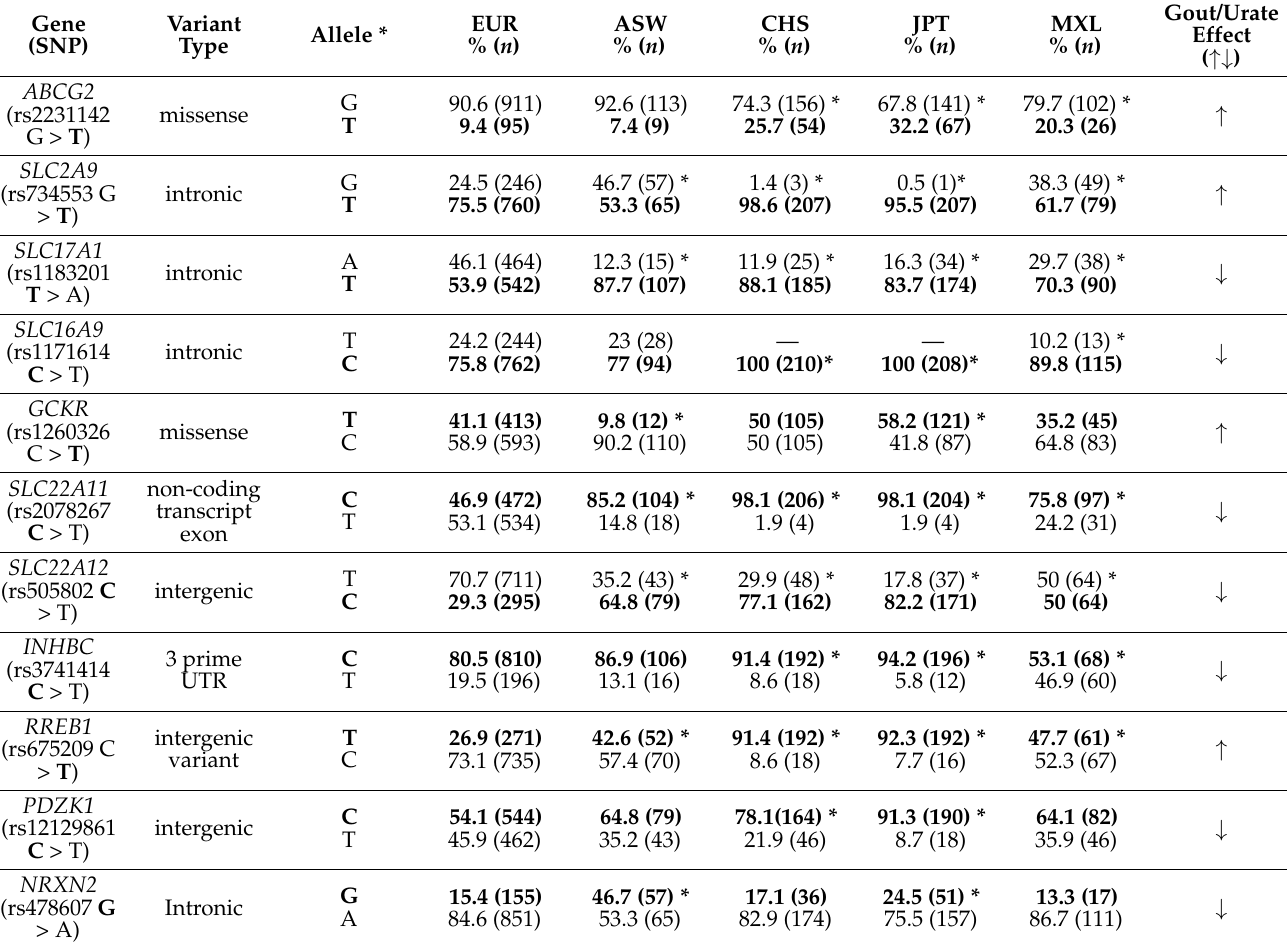
Table 2. Allele frequencies comparisons across